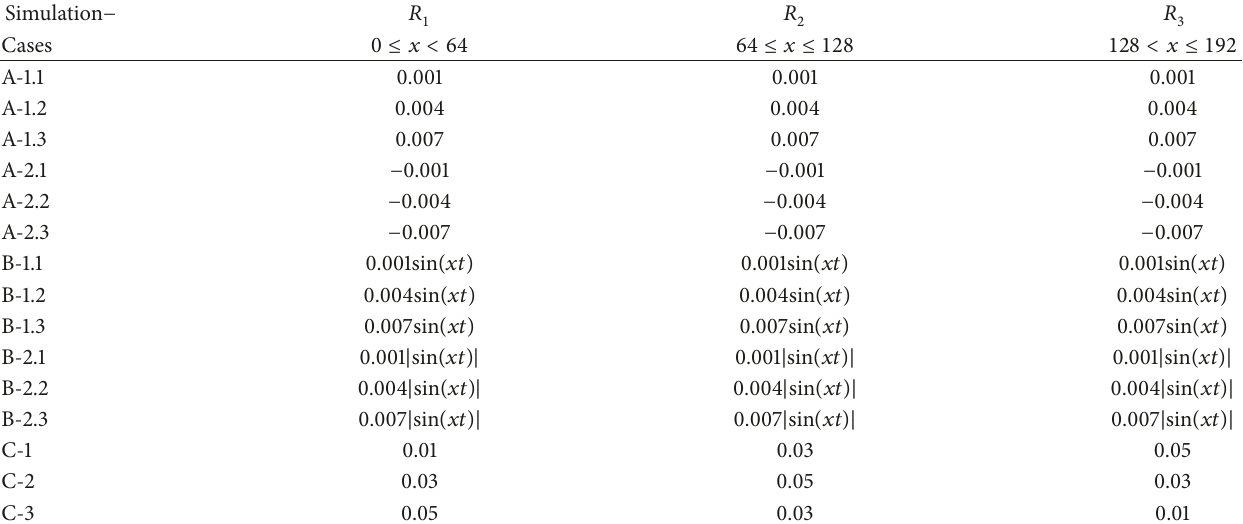
Table 1: Comparison of sources or sinks for Simulations A, B, and